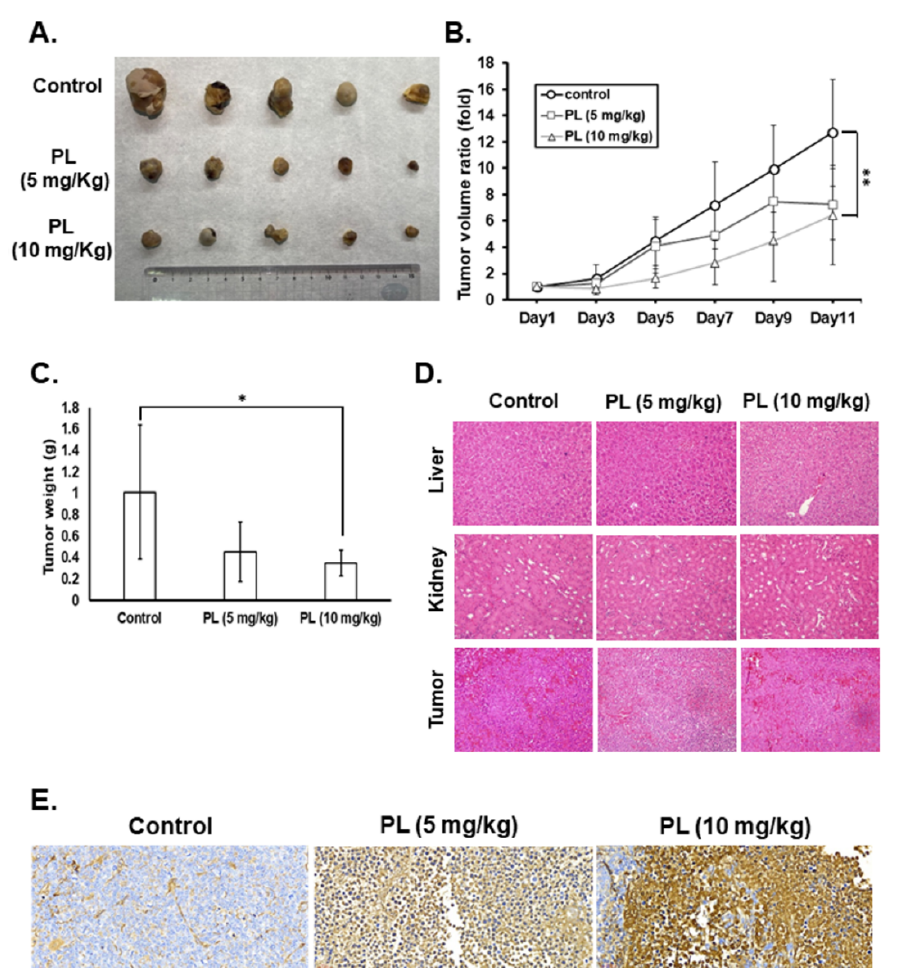
Figure 8. Piperlongumine significantly inhibited human thyroid cancer cell growth in vivo. IHH-4- bearing mice were treated with either dimethyl sulfoxide (DMSO) ( n = 5) or PL ( n = 5/group). ( A ) Representative images of excised tumors from each group. ( B ) Tumor volume and ( C ) tumor weight were measured to reflect tumor growth in vivo. ( D ) Hematoxylin and eosin staining to determine cellular pathology and immune cell infiltration. 200 × magnification. ( E ) Apoptosis in tumors was measured by terminal deoxynucleotidyl transferase-mediated nick end labeling (TUNEL) staining, and the brown staining indicates apoptotic cells. 40 × magnification. DMSO was used as a negative control. * indicates p < 0.05. ** indicates p <